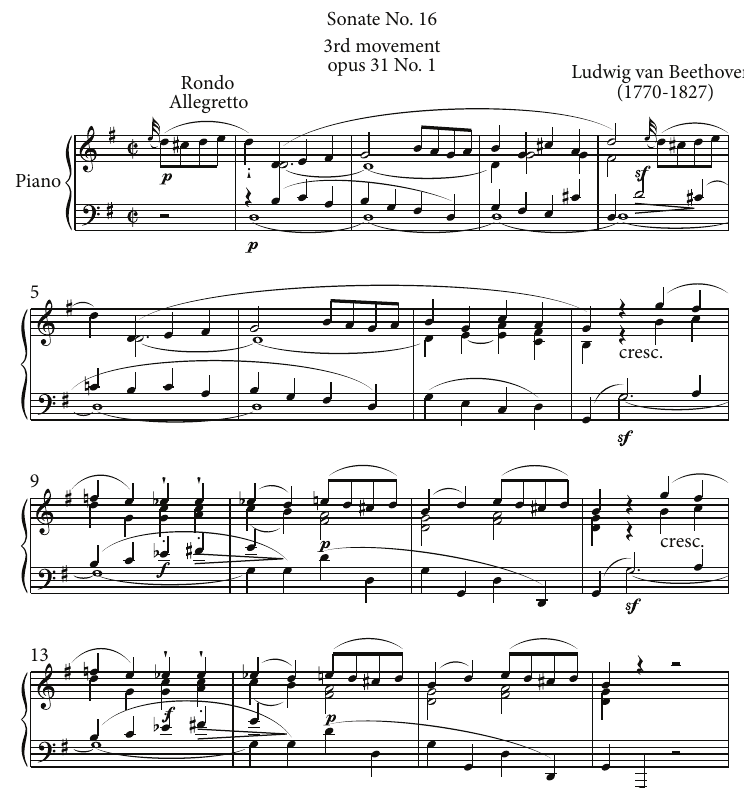
Figure 10: The music excerpt used to evaluate the CaRo 2.0 software. The score has been transcribed in MusicXML format, including all the expressive indications (slurs, articulation marks, and dynamic cues).